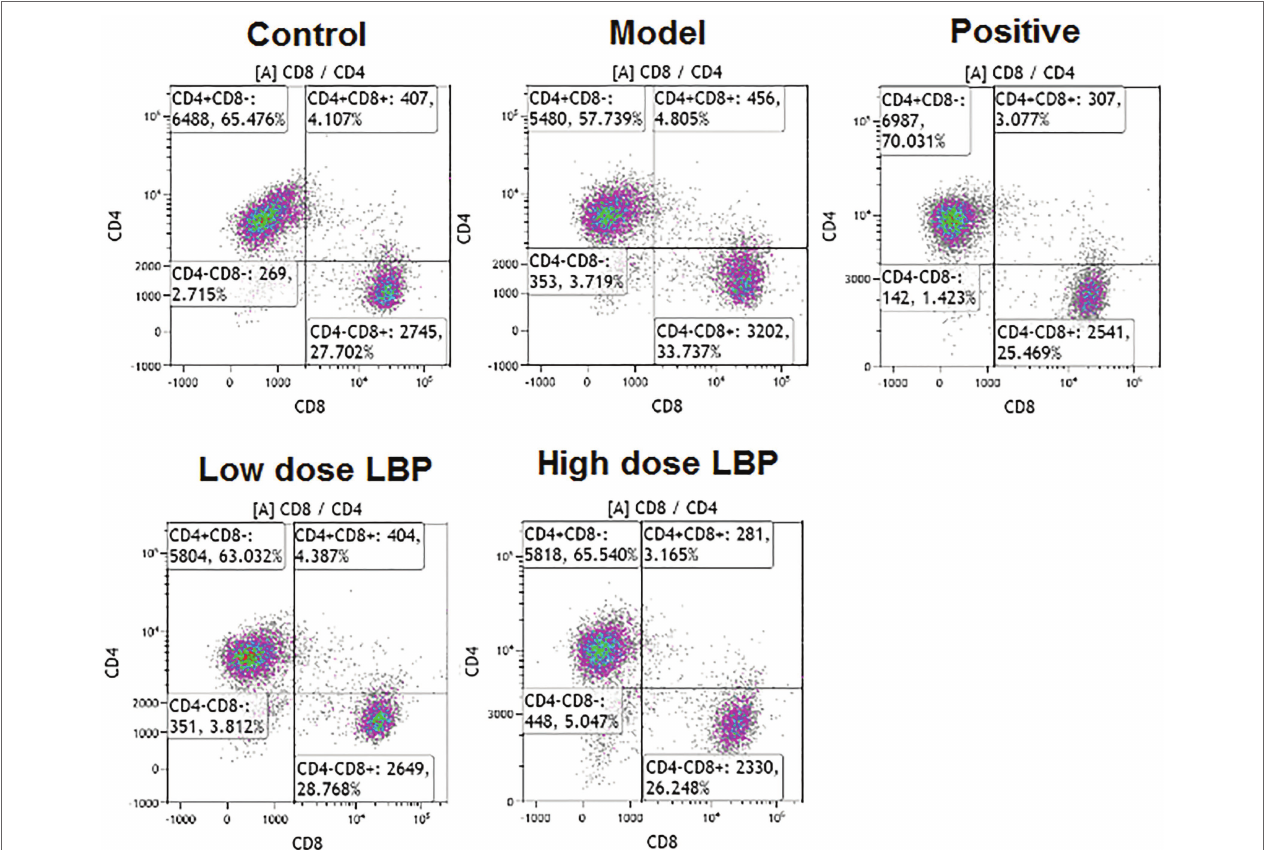
FIGURE 3 | Representative flow-cytograms depicting of CD4+ and CD8+ T cell rates among T cells in immunosuppressed mice.